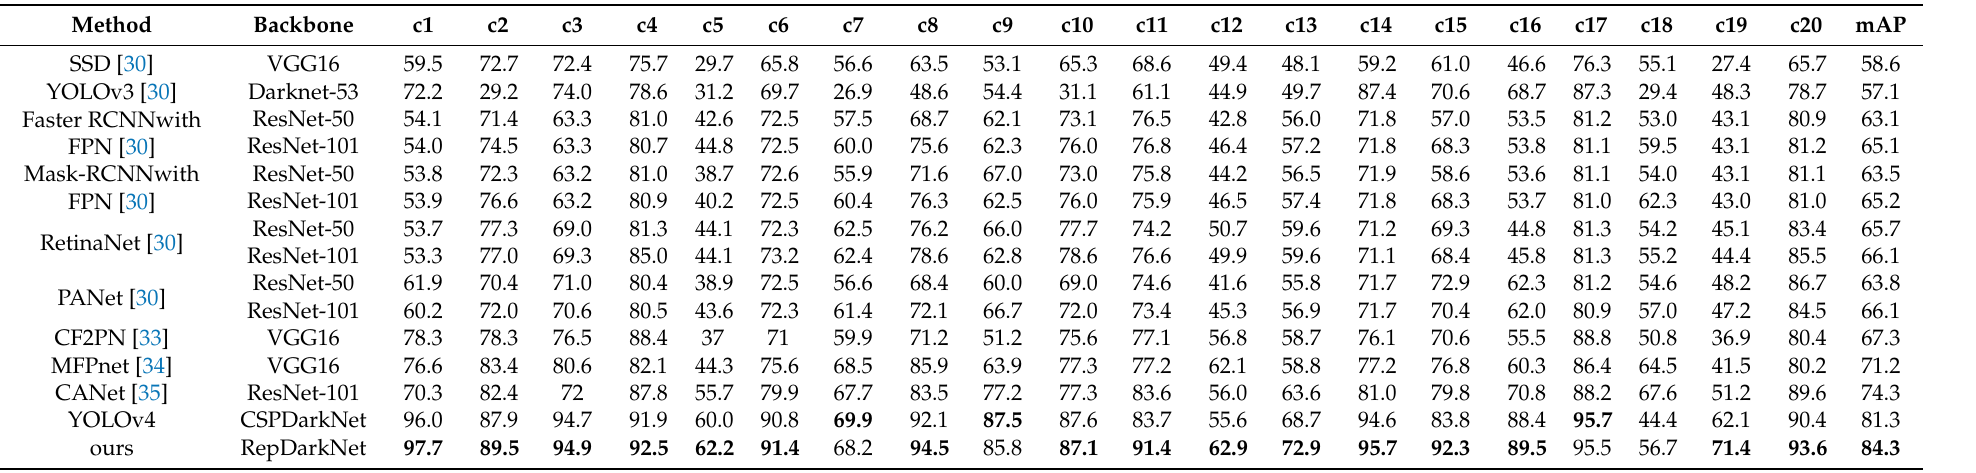
Table 4. Comparison of the results of the algorithms on the Dior